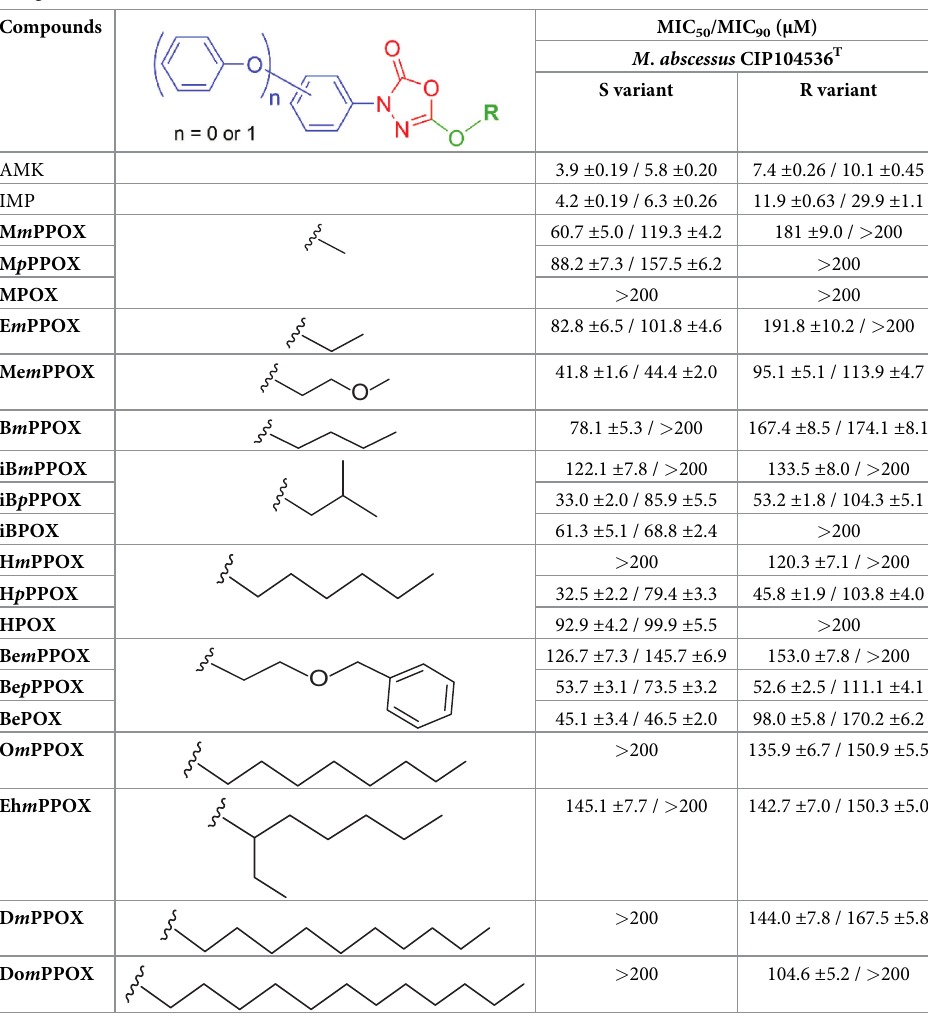
values were indicative either of a moderate (MIC 50